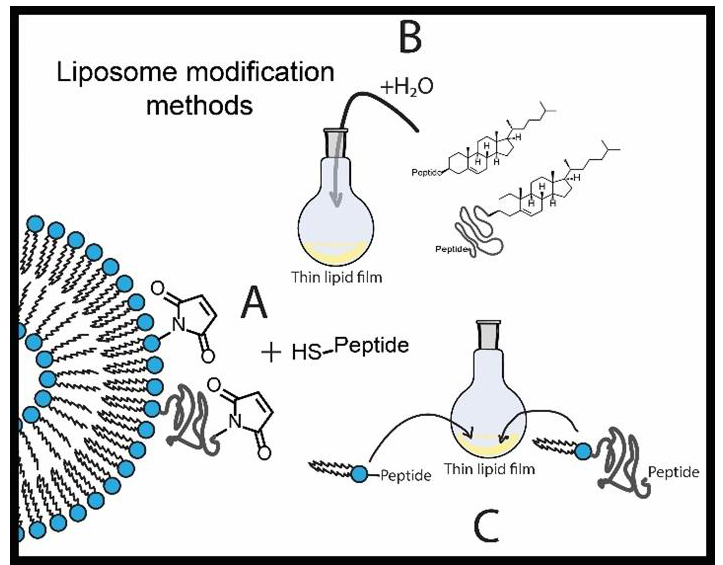
Figure 5. Different examples of liposome modification methods: ( A ) chemical conjugation to prepared liposomes (usually a fast reaction is applied such as thiol-maleimide coupling); ( B ) hydration with aqueous solutions of functionalized lipids (CHO shown as a sample anchoring moiety), or post-insertion; ( C ) incorporation of functionalized lipids to the initial lipid film. Table 1. Recent work examples (5 years to date) involving peptide-modified liposomes listed with corresponding peptides, targets or purposes, and the methods of liposome functionalization. Ref Peptides